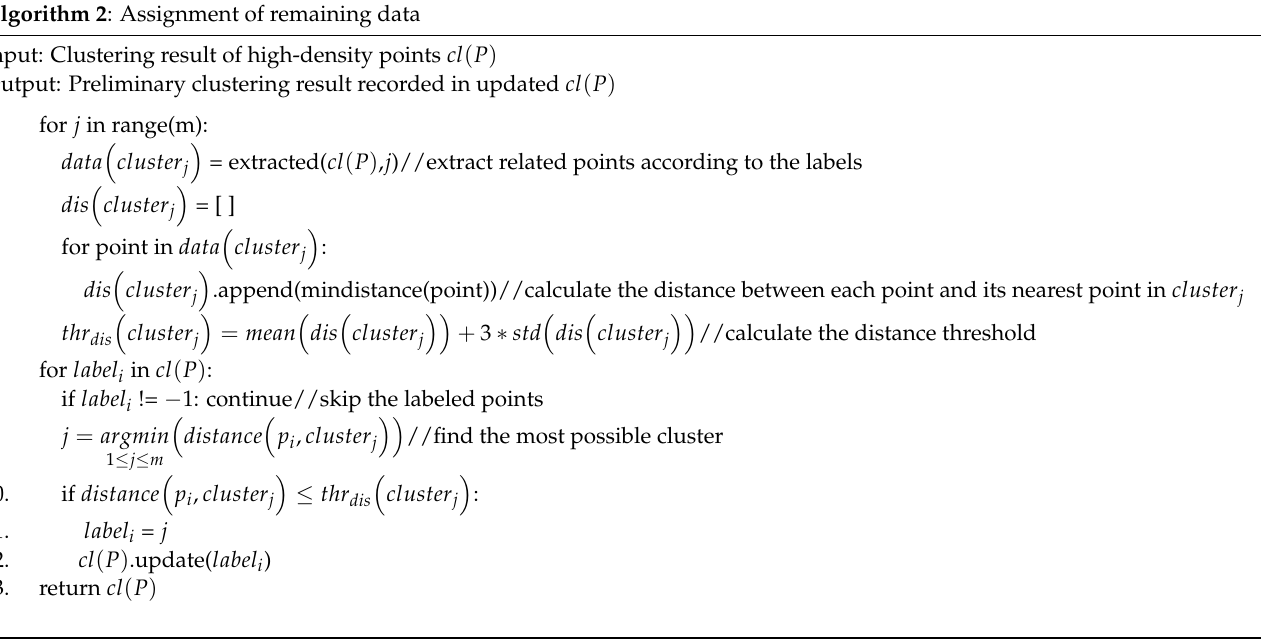
11 of 38 Figure 5. Processing flow of high-density points. The parameter eps is selected by Algorithm 1 and then high-density points can be extracted and clustered. 3.2.2. Assignment of Remaining Data All the high-density points are clustered in the above process, and the remaining points are tried to be assigned to the clusters (Algorithm 2). Figure 6 shows an example of the assignment. There are two main steps for the assignment, namely finding the most possible cluster and judging if the points meet the cluster features. In the first step, the possibility of a point belonging to a cluster is evaluated by the distance between them